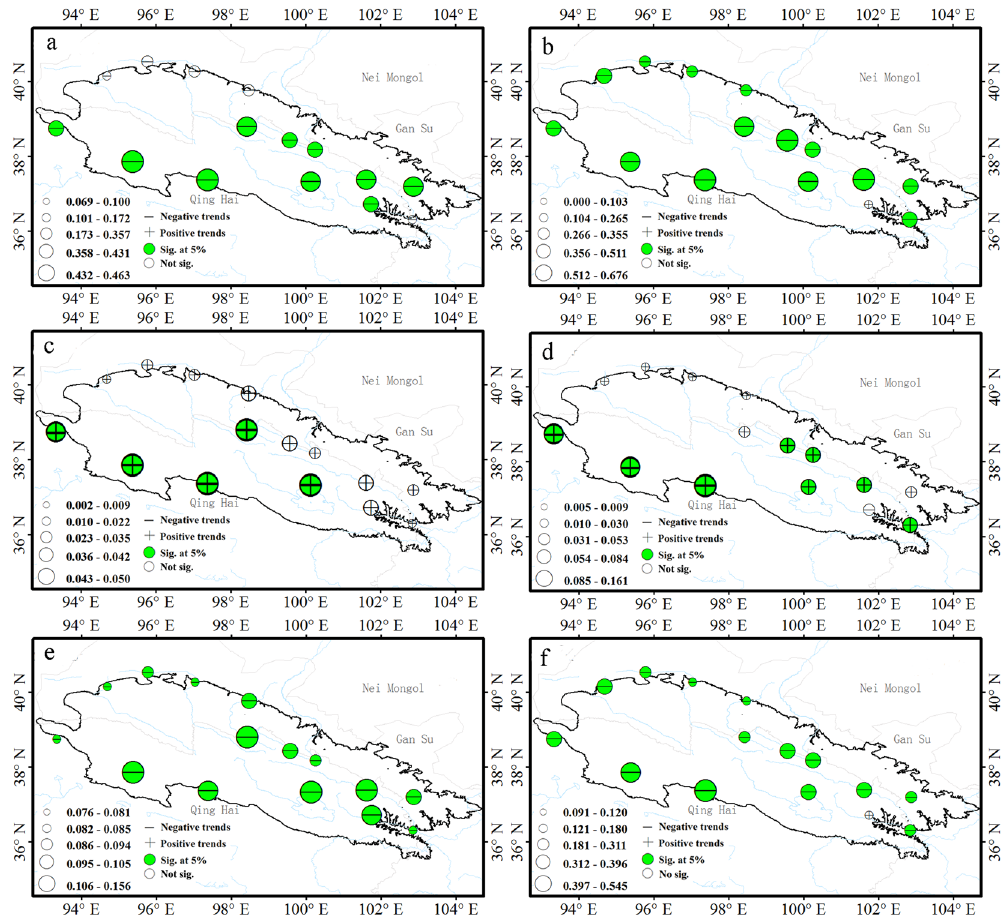
Figure 3. Spatial pattern of indices of cold-temperature extremes. Cold indices: ice days ( a ), frost days ( b ), coldest day ( c ), coldest night ( d ), cool days ( e ), cool nights ( f ). For description of indices, see Supplementary Table S1. The size of the circles is the degree of changing. Positive trends are shown as pluses, negative trends as minuses. A green symbol indicates significance at the 5%; a white symbol represents non-significant trends. The maps are generated with Arc Map Ver 10.1